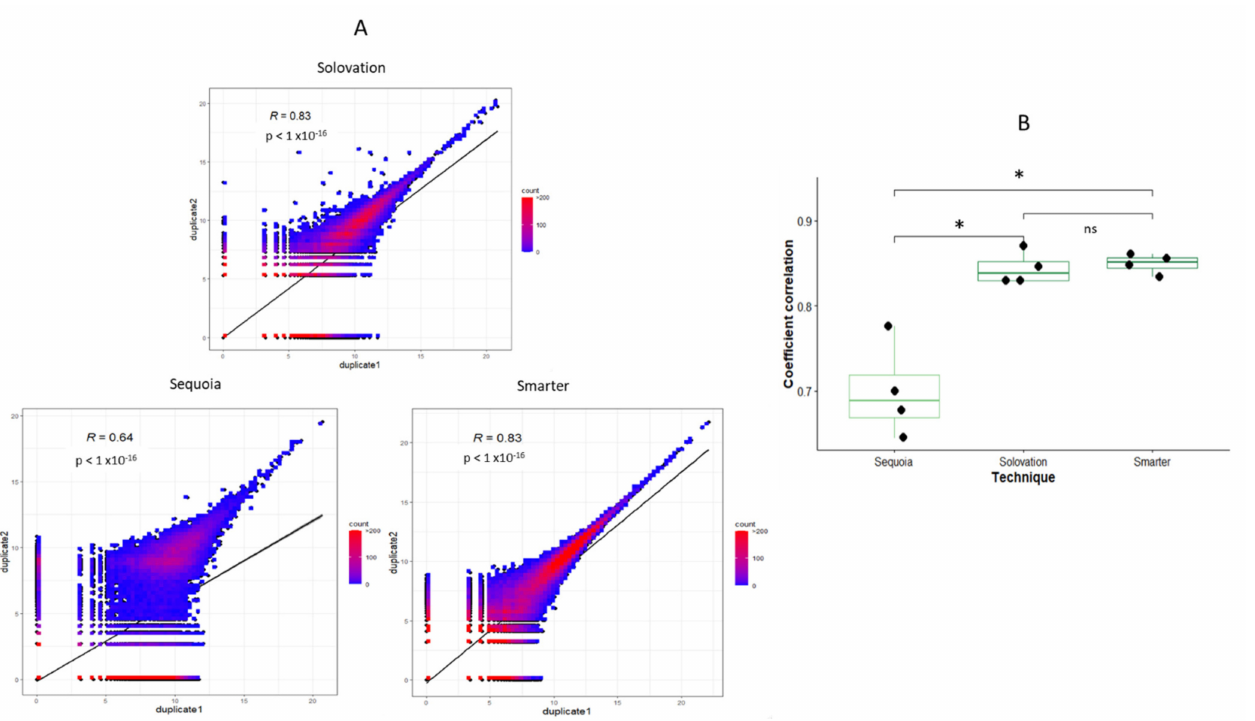
Figure 4. Reproducibility among Sequoia, Solovation, and Smarter sequencing kits. ( A ) Correlation with Spearman test of gene expression between replicates of the same kit. ( B ) Correlation between 4 replicates for Sequoia, Solovation, and Smarter. Coefficient correlations of each technique were compared using a Mann–Whitney test. The lower and upper hinges correspond to the first and third quartiles. The upper whisker extends from the hinge to the largest value no further than 1.5 * interquartile range from the hinge. The lower whisker extends from the hinge to the smallest value at most 1.5 * interquartile range of the